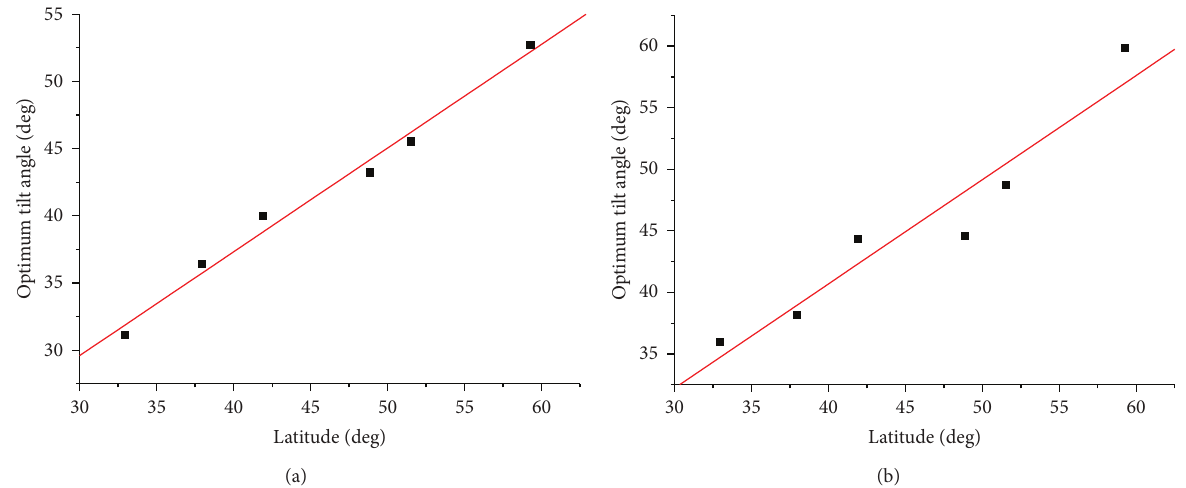
Figure 1: Average values of optimum tilt angles, computed using diffuse solar radiation models, as a function of latitude, relative to the solar declination 𝑑 9 (a) and to the solar declination 𝑑 3 (b). Linear regressions with 95% confidence interval provided the correlation coefficients 𝑟 = 0.993 and 𝑟 = 0.957 , respectively.